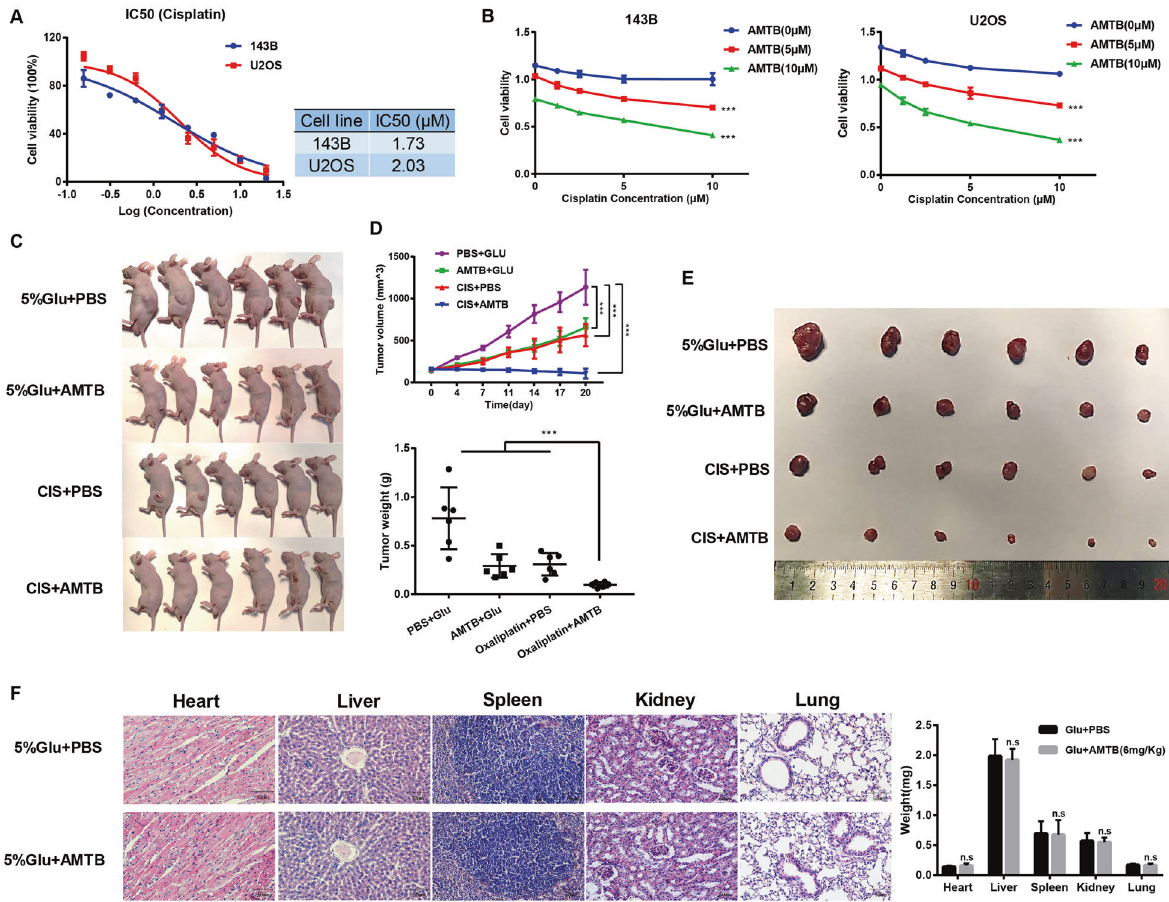
Fig. 6 AMTB can increase the sensitivity of osteosarcoma cells to cisplatin in vitro and in vivo. A IC50 values of U2OS cells and 143B cells after incubation with cisplatin for 48 h. B Combination of various concentrations of AMTB and cisplatin were used to treat osteosarcoma cells, and the results indicated that AMTB combined with low dosage of cisplatin exhibited stronger suppressive effect compared with high dosage of cisplatin alone. The data was compared by two-way ANOVA with Bonferroni test and shown as mean ± s.d. *** P < 0.001. C Preclinical experimental model of osteosarcoma induced by subcutaneous injection of osteosarcoma cells into the back of the mice. n = 6. D Tumor volume was recorded every two days after indicated treatment, and tumors were removed and weighted at the termination of the study. The data was compared by two-way ANOVA with Bonferroni test and shown as mean ± s.d. *** P < 0.001. E The isolated xenograft tumors from treated or control group were shown. n = 6. F Vital organs amongst different treatment groups were weighted and showed no signi fi cant difference. H&E staining of vital organs amongst different treatment groups indicated that no histologic changes were induced by ATMB treatment. The data was compared by one-way ANOVA with Tukey ’ s multiple comparison test and shown as mean ± s.d. ** P < 0.01, *** P <